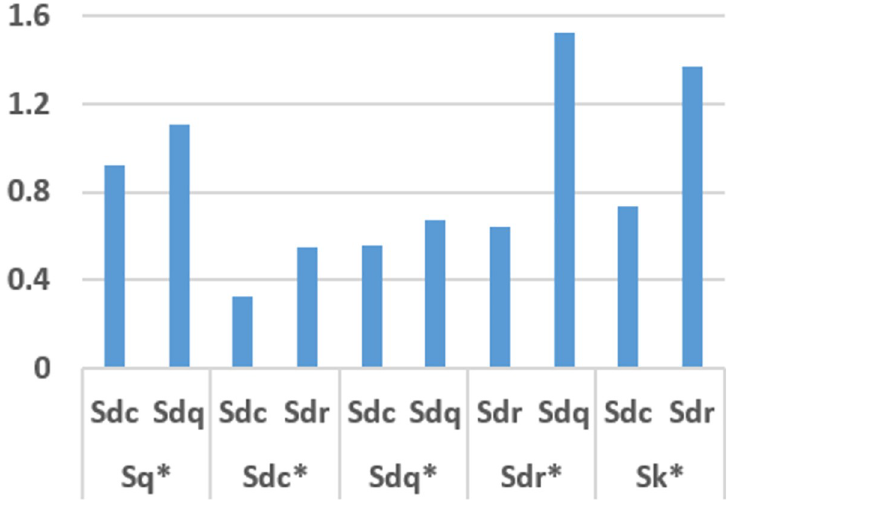
Fig 13. Verification of the influence